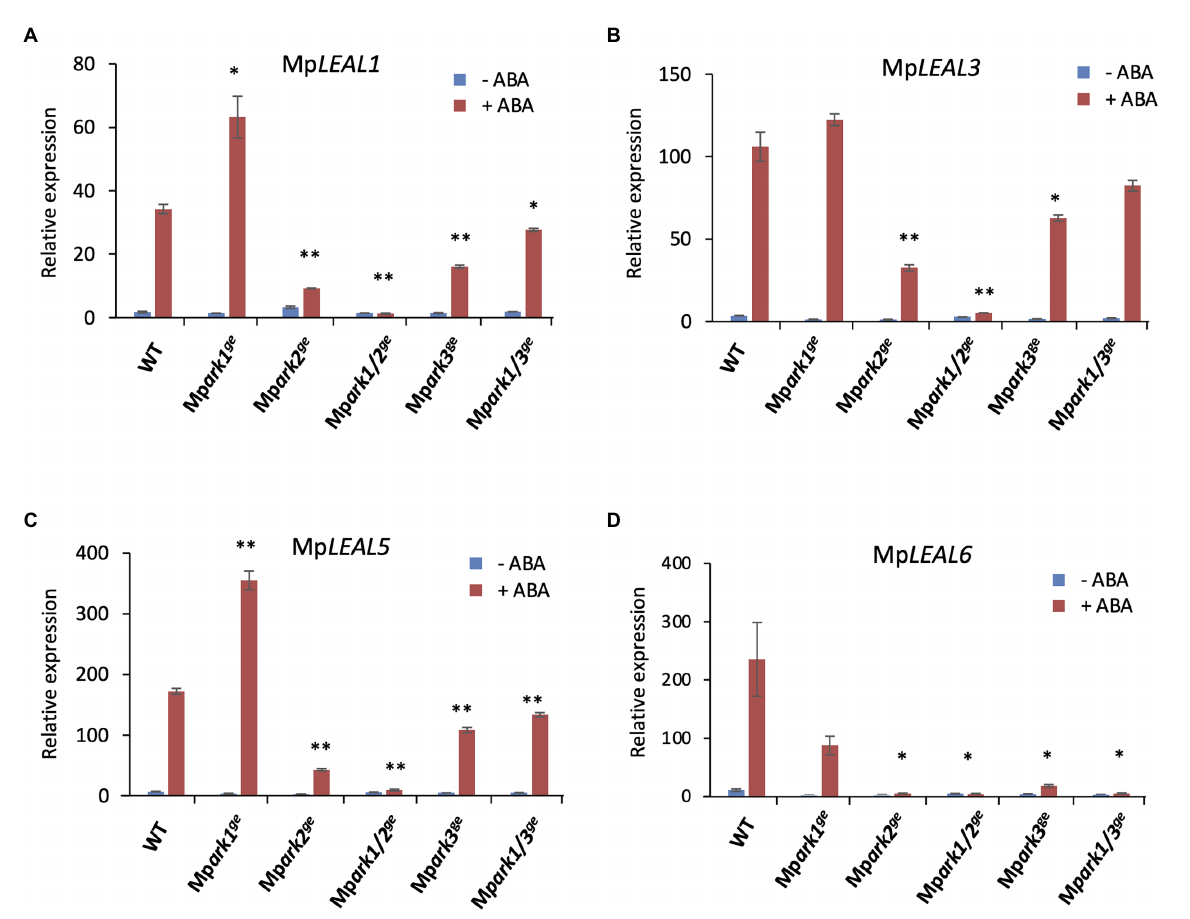
FIGURE 7 ABA-induced expression of LEA- like genes in wild type (WT) and B3-Raf genome editing lines. Quantitative RT-PCR analysis was carried out using RNA isolated from gemmalings treated with or without 10 μ M ABA. Transcripts for Mp LEAL1 ( Mapoly0112s0030 ) (A) , Mp LEAL3 ( Mapoly0035s0082 ) (B) , Mp LEAL5 ( Mapoly0087s0015 ) (C) , and Mp LEAL6 ( Mapoly0027s0114 ) (D) were analyzed. Relative values were determined by SYBR green-based quantitative PCR analysis using Mp EF1 ( Mapoly0024s0116 ) unaffected by ABA as a reference. Error bars indicate +/ − SE. * p < 0.05, ** p < 0.01 by t -test ( n = 3) compared with WT of the same